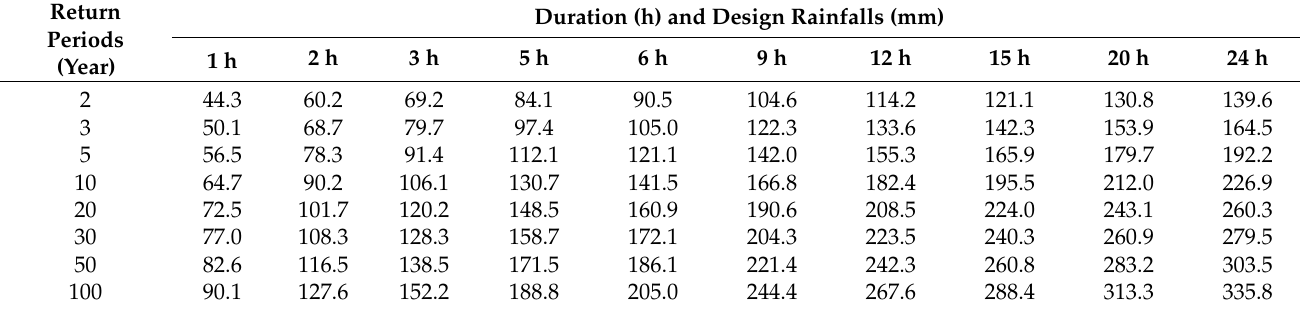
Table 3. Design rainfalls by return periods and rainfall durations.